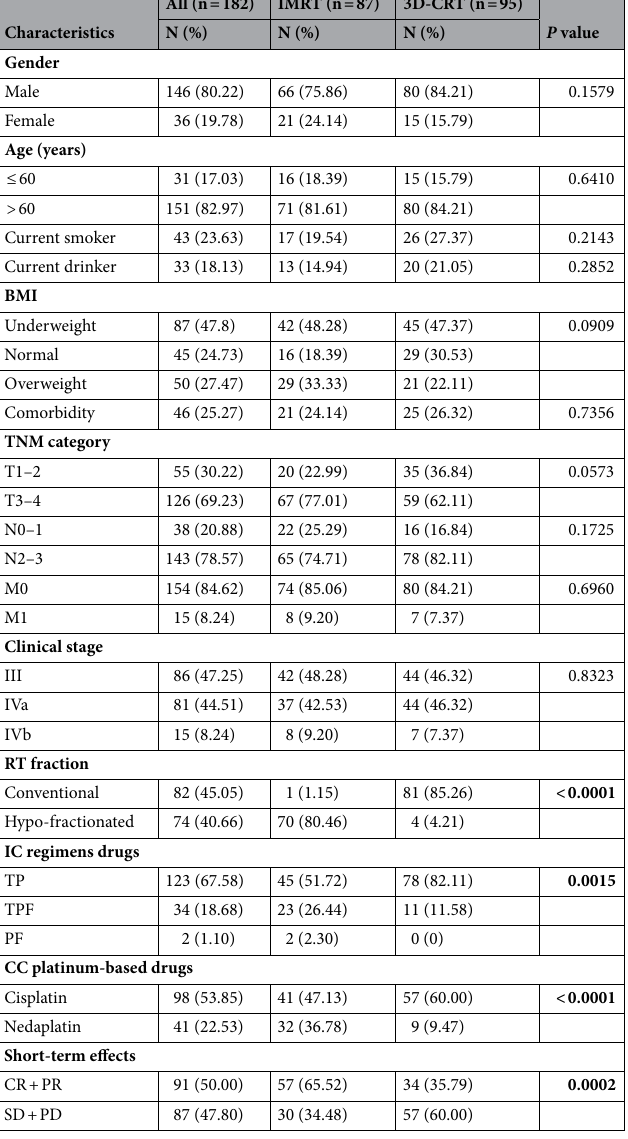
Table 1. Demographics and clinical characteristics. IMRT intensity modulated radiation therapy, 3D-CRT three-dimensional conventional radiotherapy, RT radiotherapy, IC induction chemotherapy, CC concurrent chemotherapy, CR complete remission, PR complete remission. P values were calculated with Chi-square ( χ 2) test or Fisher’s exact test. The use of bold formatting means P <